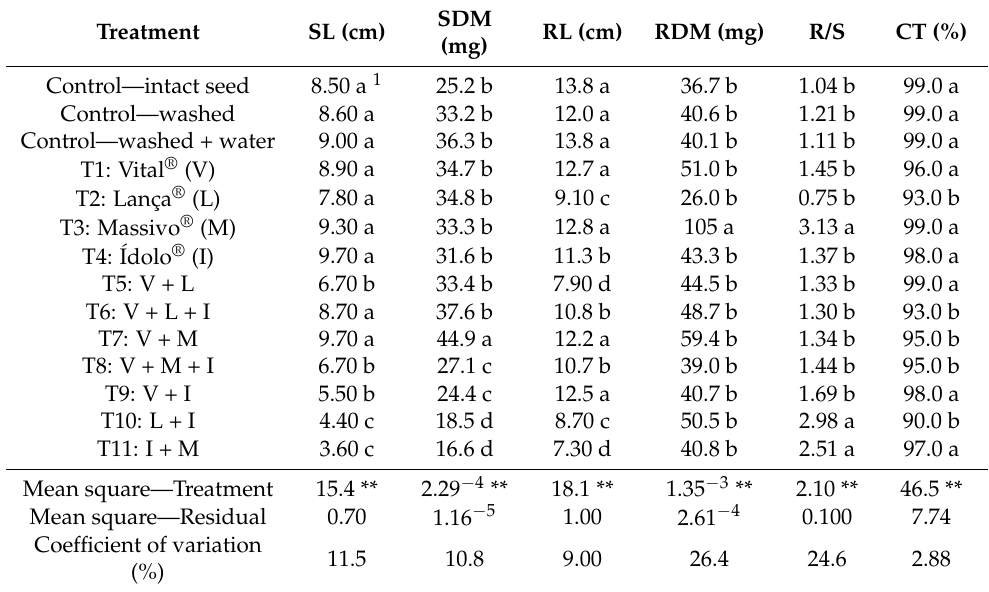
Table 5. Average shoot length (SL), shoot dry matter (SDM), root length (RL), root dry matter (RDM), and root-to-shoot ratio (R/S) of corn seedlings and cold test (CT) of corn MG744 PWU seeds from different seed treatments. Jata í , GO, Brazil,